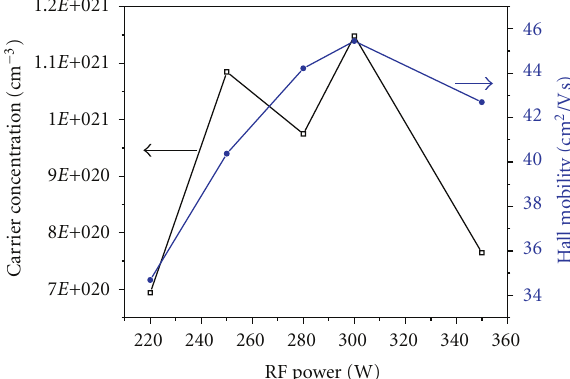
Figure 6: Resistivity of the ITiO film with variations of RF power.